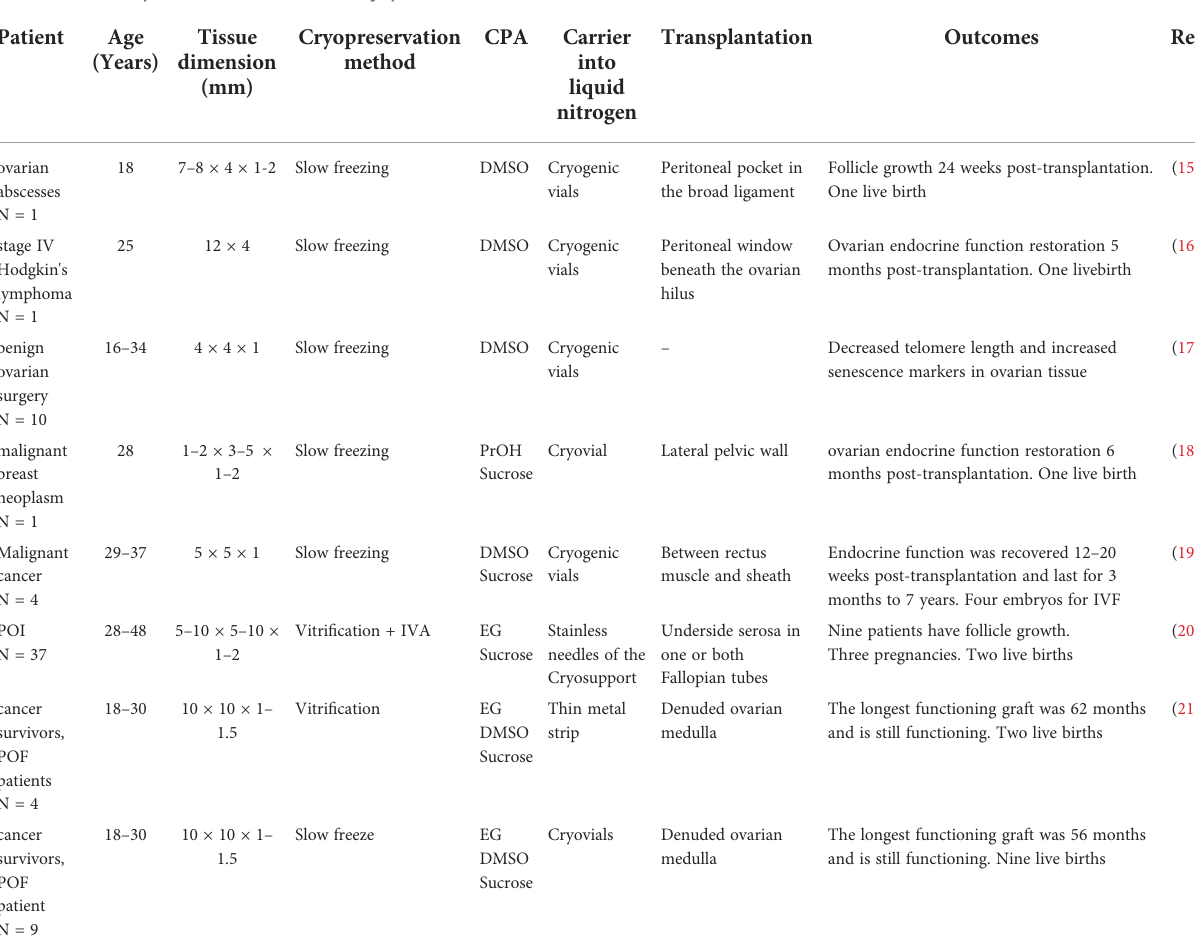
TABLE 1 Clinical practice of ovarian tissue